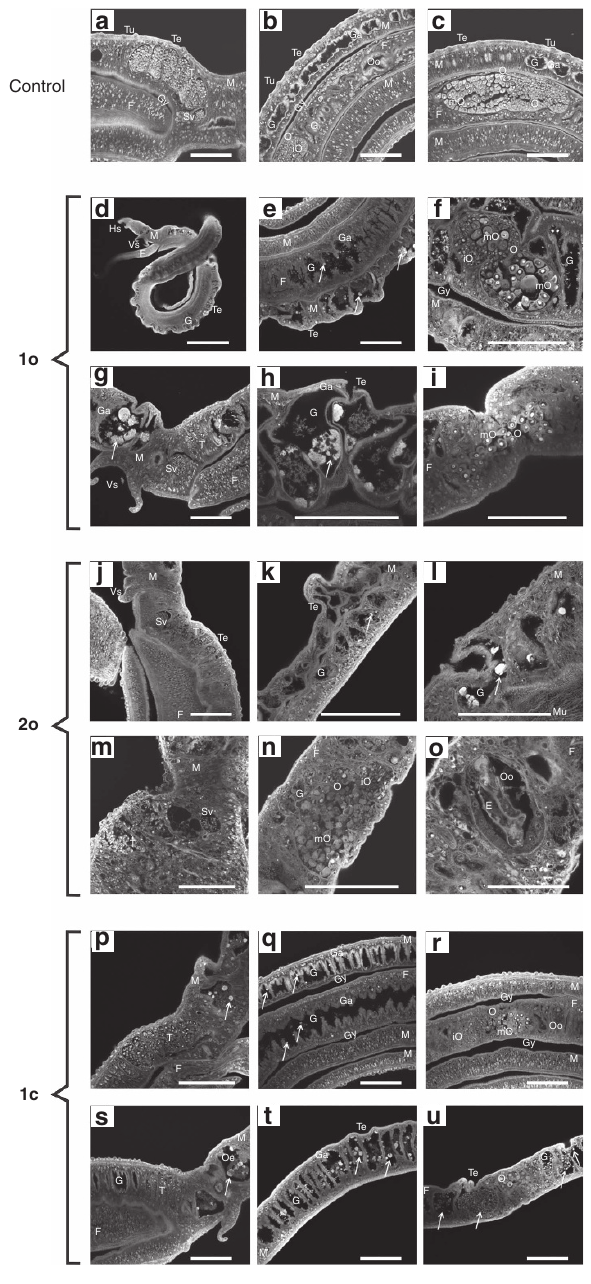
sucker; M, male; T, testis; Te, tegument; Tu, tubercle: O, ovary; Oe, oesophagus; mO, mature oocytes; iO, immature oocytes; Oo, ootype; Sv, seminal vesicle; Vs, ventral sucker. Scale bars, 100 m m, except d (400 m m) and o (50 m